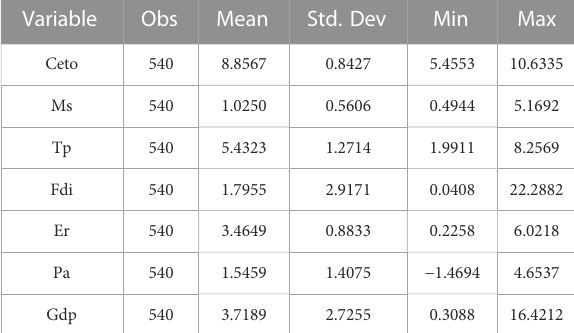
TABLE 2 Descriptive statistical analysis of each variable.